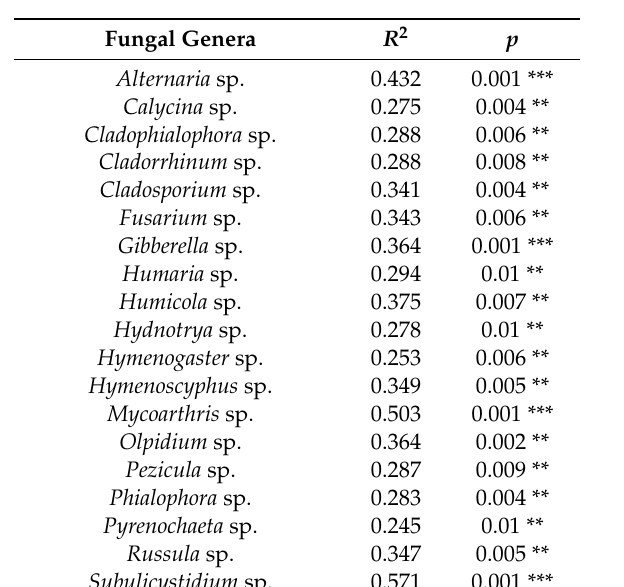
Table 3. Goodness-of-fit statistics ( R 2 ) for fungal genera fitted to the two-dimensional non-metric multidimensional scaling (2D-NMDS) ordination of root-associated fungal communities in di ff erent tru ffl e-producing forest types in Serbian riparian forests. p values: ** = p < 0.01, *** = p <